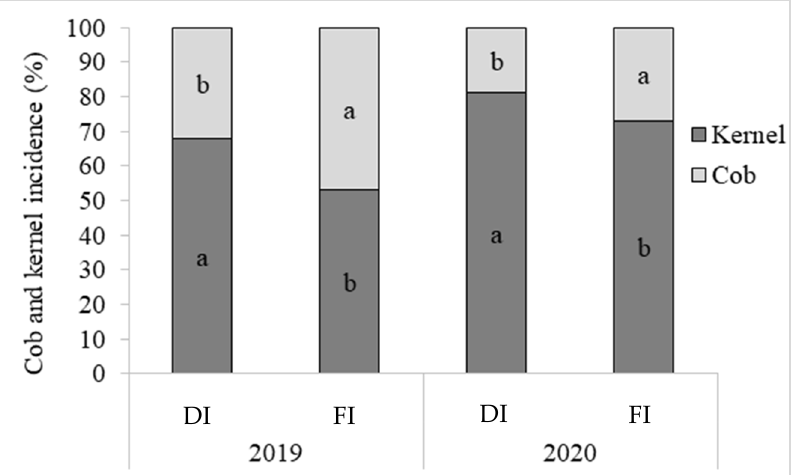
Figure 4. Dry kernel and cob incidence (%). Kernels and cobs percentages were statistically analyzed separately. Data with different letters indicate significant difference at ( p ≤ 0.05).